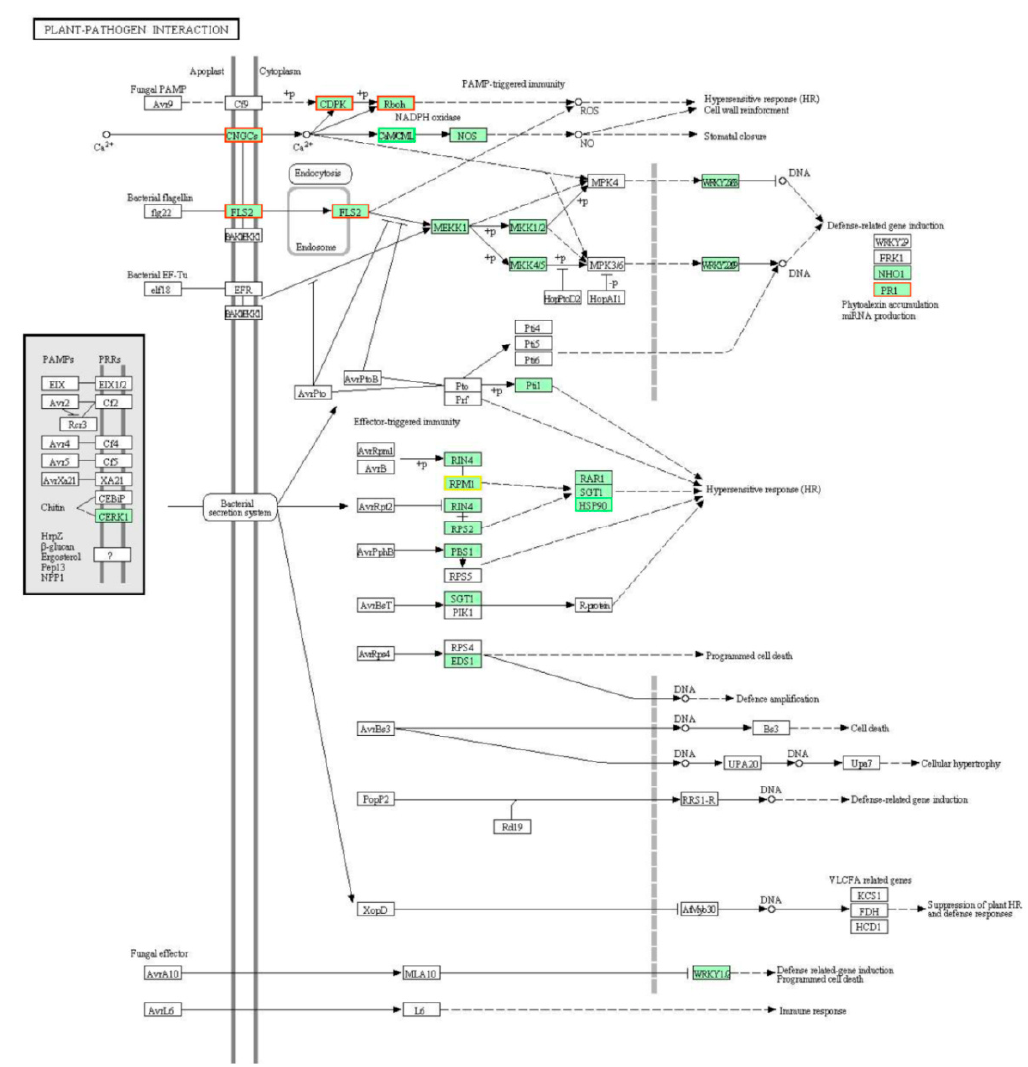
Figure 2. The “plant–pathogen interaction” KEGG pathway annotations for the identified DEGs. Nodes of KEGG pathway enriched with DEGs were colored in green. Detailed information for the significant upregulated (frame in red color) or downregulated (frame in bright green color) DEGs was presented in Table 1.